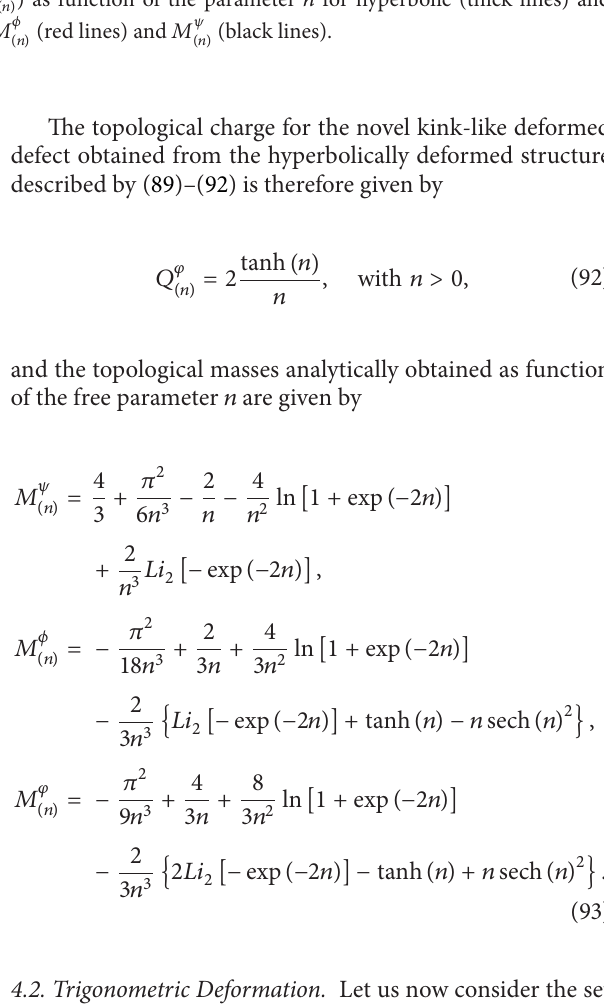
𝜙 𝑀 𝜓 (𝑛) (red lines) and (𝑛) (black lines).